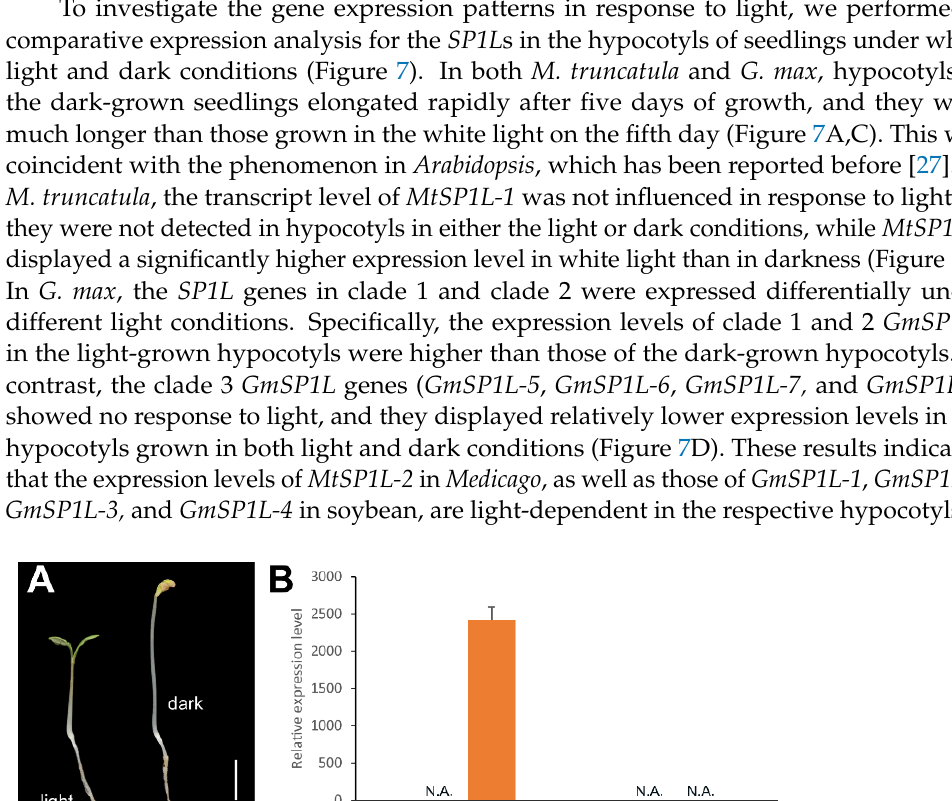
Figure 6. Tissue expression profiles of the SP1L s in Medicago and soybean. ( A ) The expression pro- files of two MtSP1L genes in different tissues retrieved from the GeneChip dataset. ( B ) The expres- sion levels of the MtSP1L genes in various tissues verified by qRT-PCR. ( C ) The transcriptional lev- els of eight GmSP1L genes in different tissues of soybean were analyzed using the public data in Phytozome. ( D ) The expression levels of the GmSP1L genes in various tissues of Williams 82 verified by qRT-PCR. The color scale shows increasing expression levels from blue to red in ( A , C ). The qRT-PCR results are expressed as the ratio of SP1Ls expression normalized against the expression of the reference genes. All data represent the means ± SDs of three biological replicates. ‘N.A.’ indicates undetectable expression.